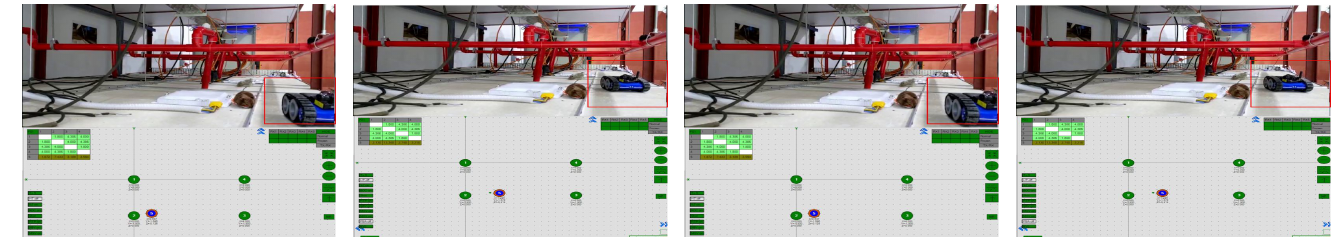
Figure 10. UWB tracking results of the Falcon robot in the Oceania Robotics false ceiling testbed.